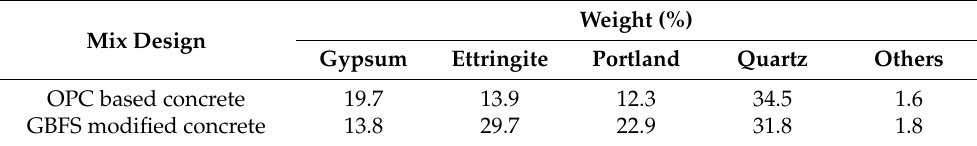
Table 6. The XRD results of the OPC based and GBFS modified concrete subjected to the acid attack.